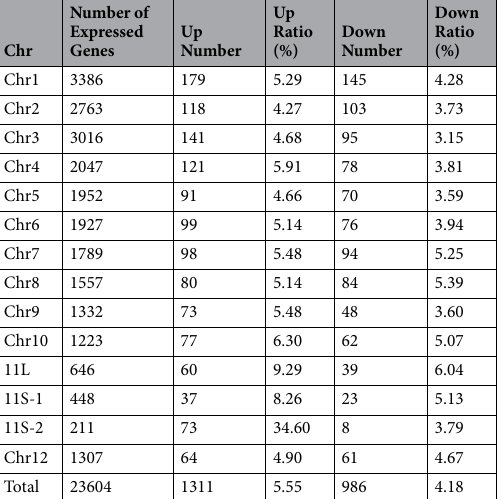
Table 1. Statistical analysis of differentially expressed genes on each